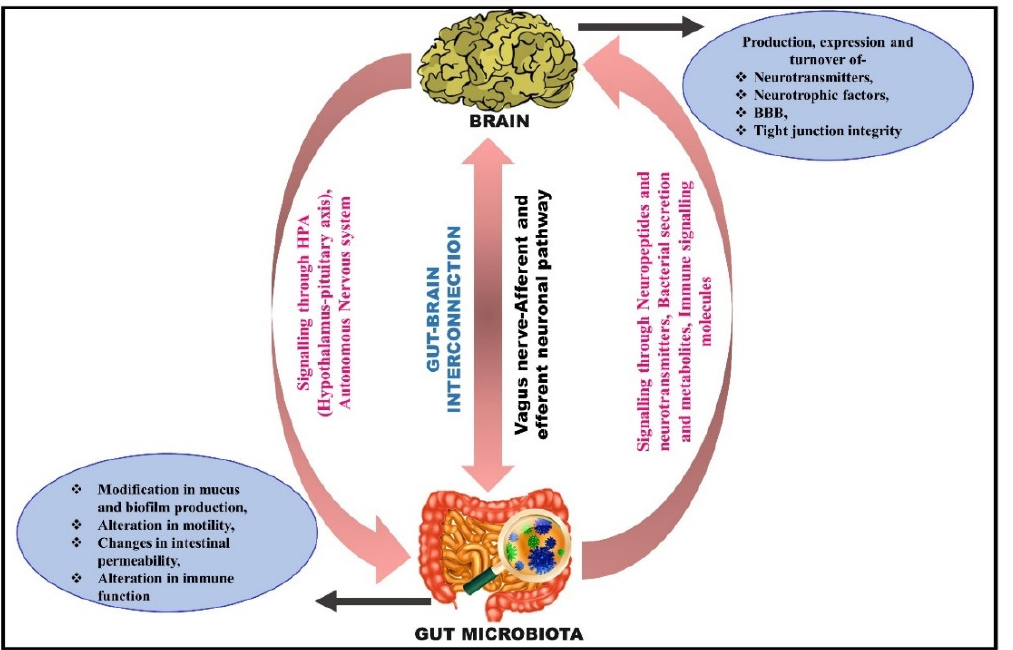
Figure 2. Illustrative diagram depicting the interconnection between gut and brain. The proposed bidirectional communication is firmly affected by various pathways, including the autonomic nervous system (ANS), hypothalamic–pituitary–adrenal (HPA), immune pathways, enteric nervous system (ENS), endocrine pathways, and neural pathways. Gut microbiota can produce microbial metabolites that activate the neuroenteric plexus, stimulate neuropeptide production in the brain, and increase gut–blood barrier and blood–brain barrier (BBB) permeability. The brain releases molecules that stimulate the function of the gut and neuroendocrine plexus.